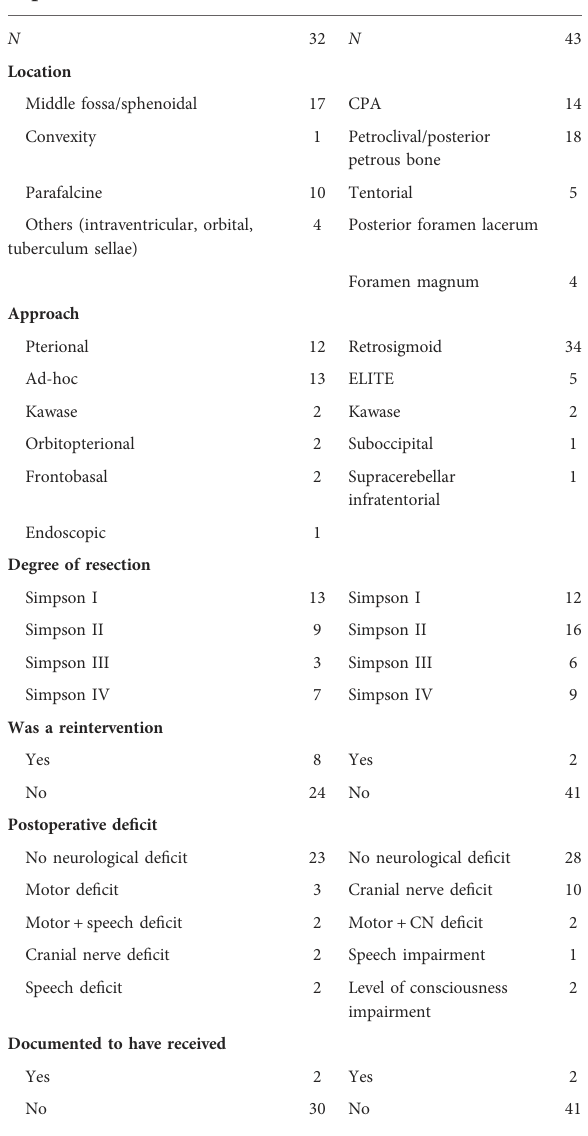
TABLE 1 Results summarized. Aggregated data according to supratentorial or infratentorial location